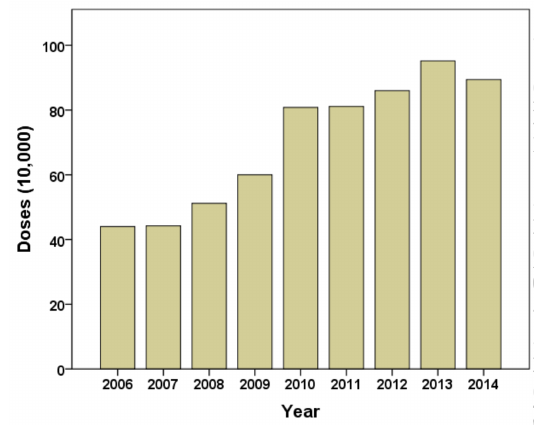
Figure 1. Annual distribution of JE vaccination doses at the provincial level (2006–2014).